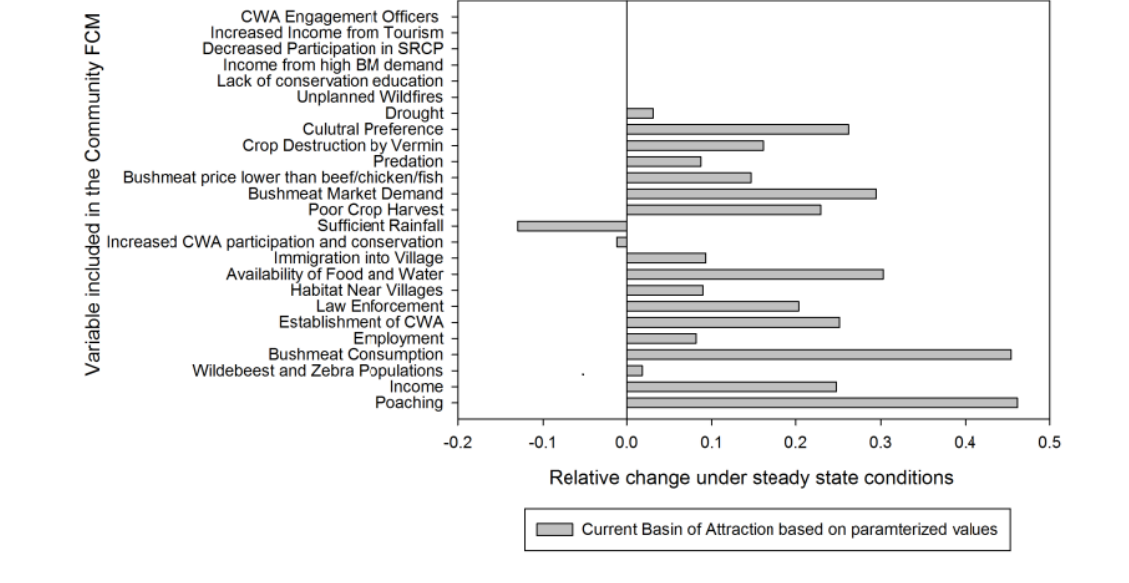
Fig. 5 . Scenario analysis of steady state that indicates the current basin of attraction for state space variables under status quo conditions independent of environmental or social change. BM indicates bushmeat; CWA, community wildlife management area; FCM, fuzzy cognitive mapping; SRCP, a local microcredit lending